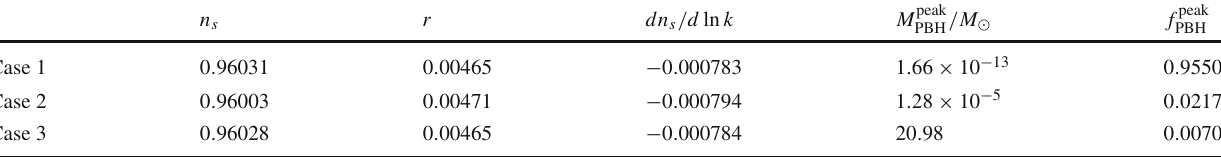
Table 2 Results of the scalar spectral index n s , the tensor-to-scalar ratio r , the running of the scalar spectral index dn s / d ln k , the mass of the corresponding PBHs M peak , and the PBH fractional abundance f PBH for the three cases of Table 1. The inflationary observables n s , r , and dn s / d ln k PBH are found at the CMB scale corresponding to N ∗ = 60